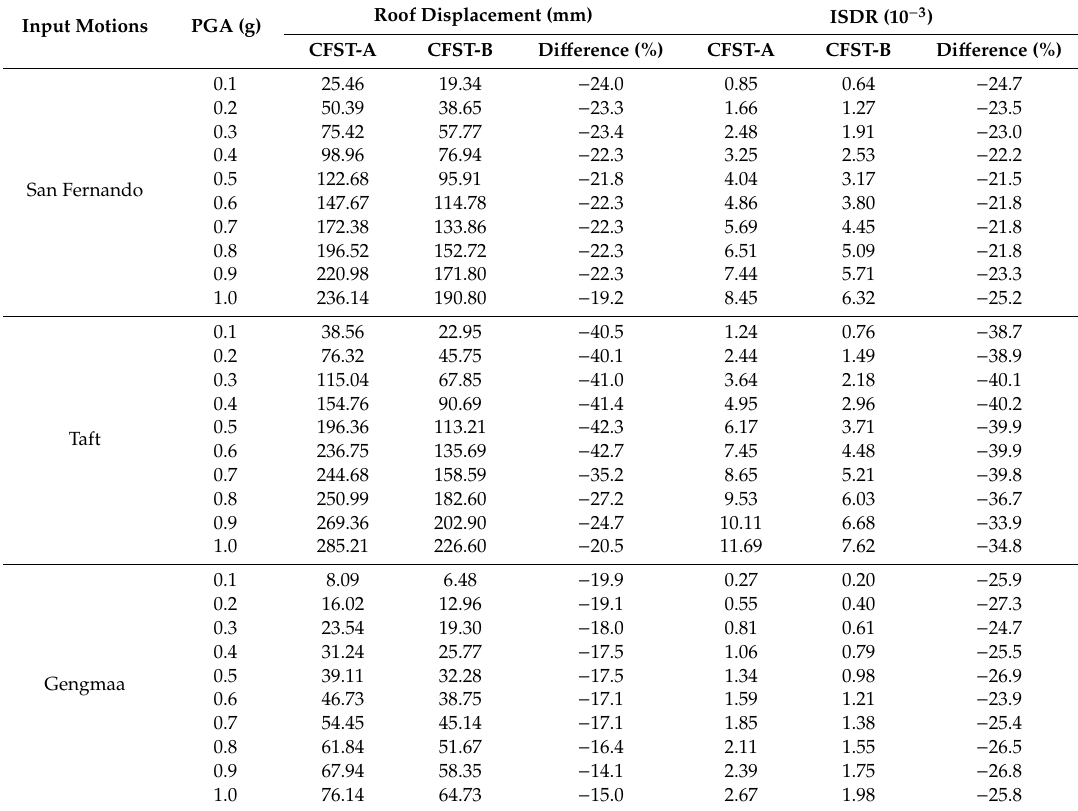
Table 2. The comparison of a structural response between CFST-A and